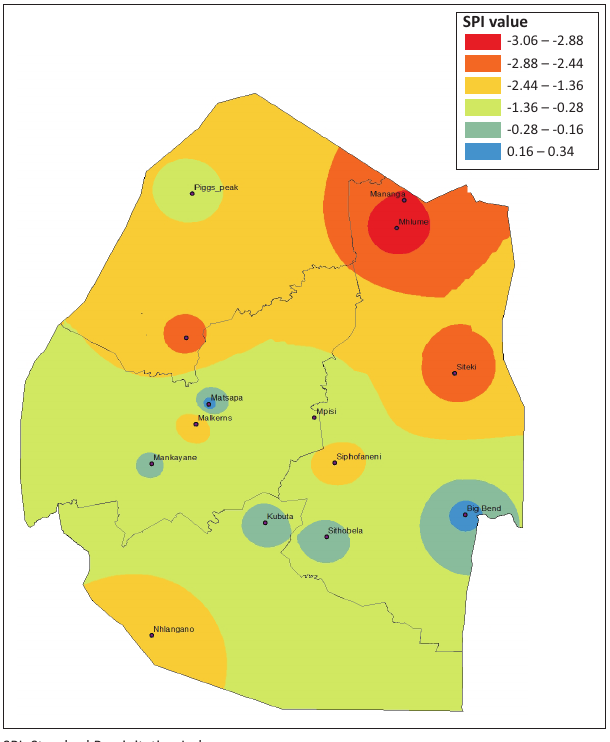
FIGURE 9: Standard Precipitation Index 3-month timescale during